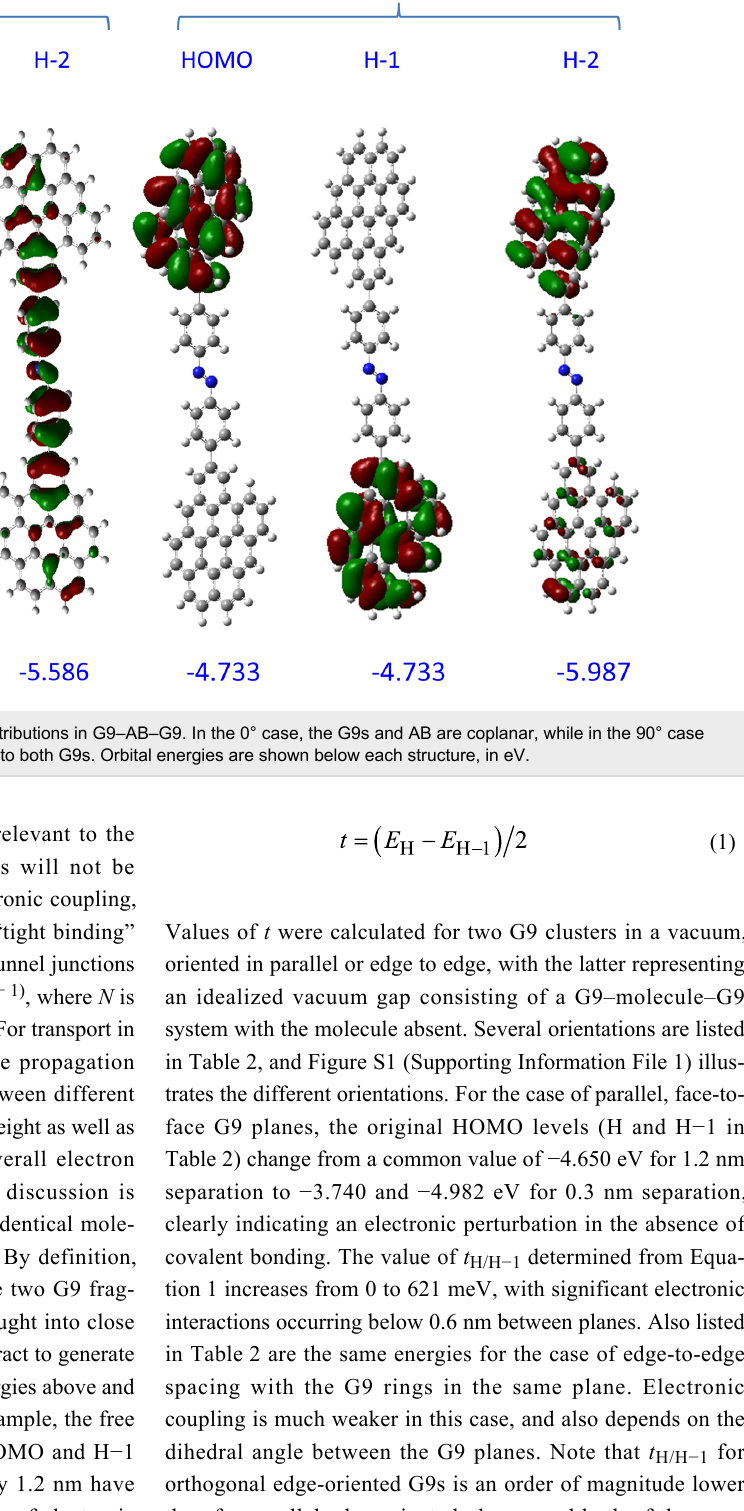
coupling. The parameter “ t ” is given by Equation 1, and is zero